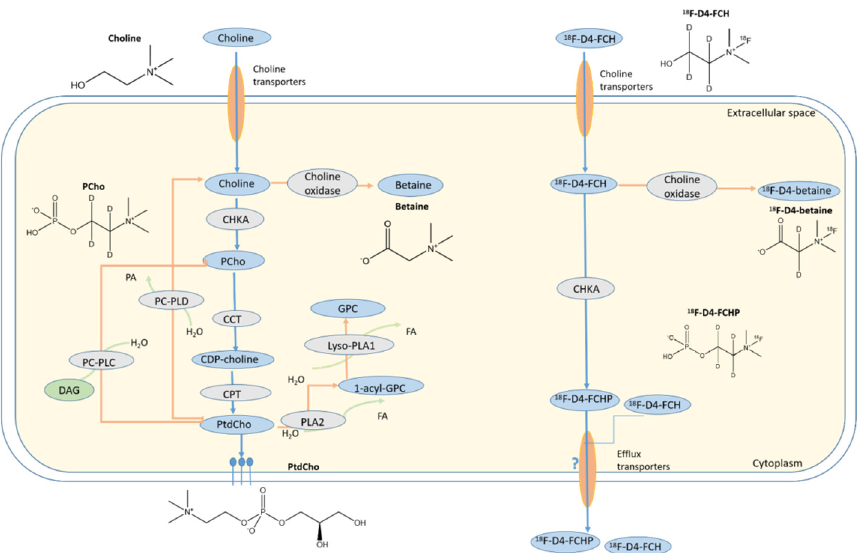
Figure 1. Chemical structures of the choline species and the regulation of choline metabolism. Blue ovals and grey ovals represent the intermediates and enzymes in the pathway. Blue arrows indicate the CDP-choline pathway towards the anabolic synthesis of PtdCho, whereas the arrows in orange indicate the catabolic pathway of PtdCho. Abbreviations: CCT, cytidine choline transferase; CDP-cytidine diphosphate choline; CHPT1, diacylglycerol choline phosphotransferase 1; DAG, diacylglycerol; HIF, hypoxia-inducible factor; FA, fatty acid; GPC, glycerophoshocholine; Lyso-PLA1, lysophospholipase A1; PC-PLC, phosphotidylcholine-specific phospholipase C; PA, phosphatidic acid; PC-PLD, phos-photidylcholine-specific phospholipase D; CTP, choline phosphotransferase; PCho, phosphocholine; PtdCho, phosphotidylcholine.